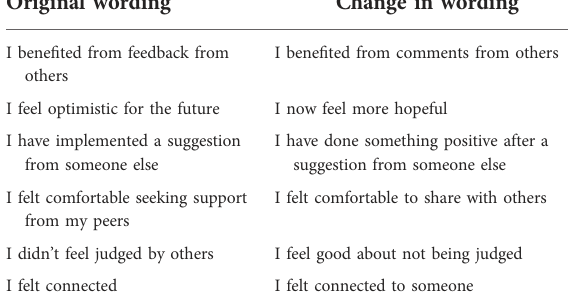
TABLE 4 Changes made to the wording of items for the third part of the measure during the fi nal round. Original